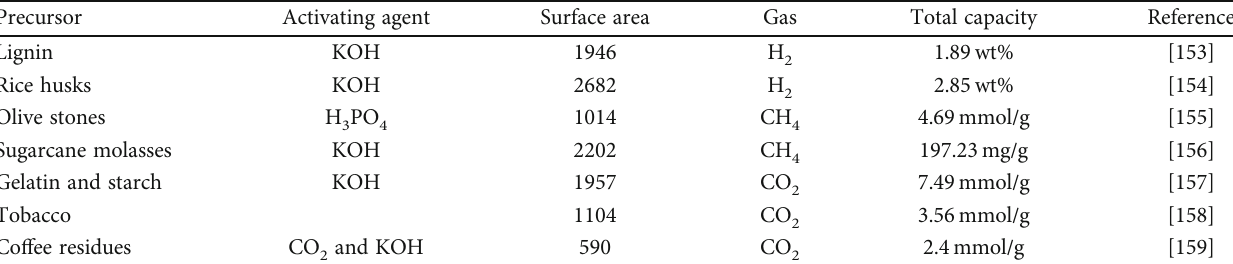
Figure 7: Hydrolysis of cellulose to glucose [142]. Table 7: Activated carbon as a storage material for various